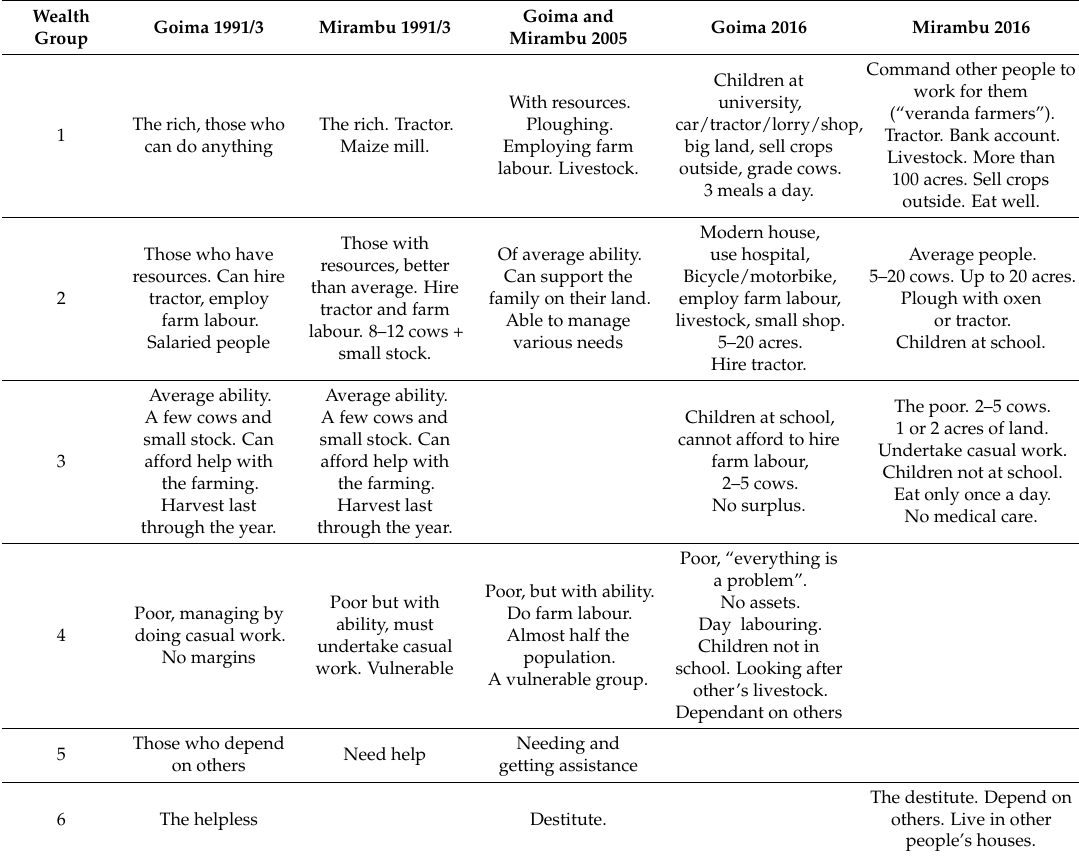
Table 11. Changing Definitions of wealth Goima and Mirambu villages,